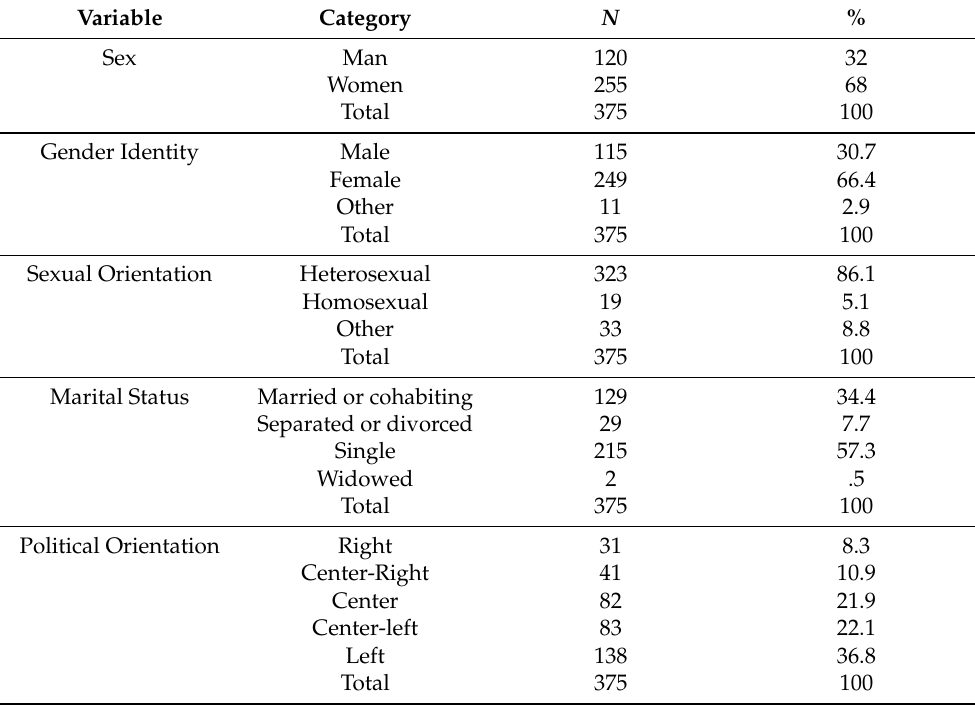
Table 1. Sociodemografic characteristics of the